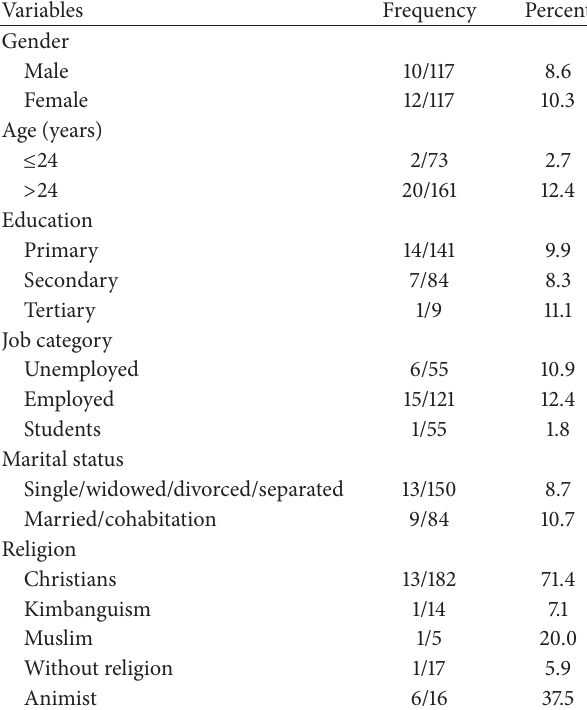
Table 3: HIV positive tests in 234 study participants according sociodemographics and